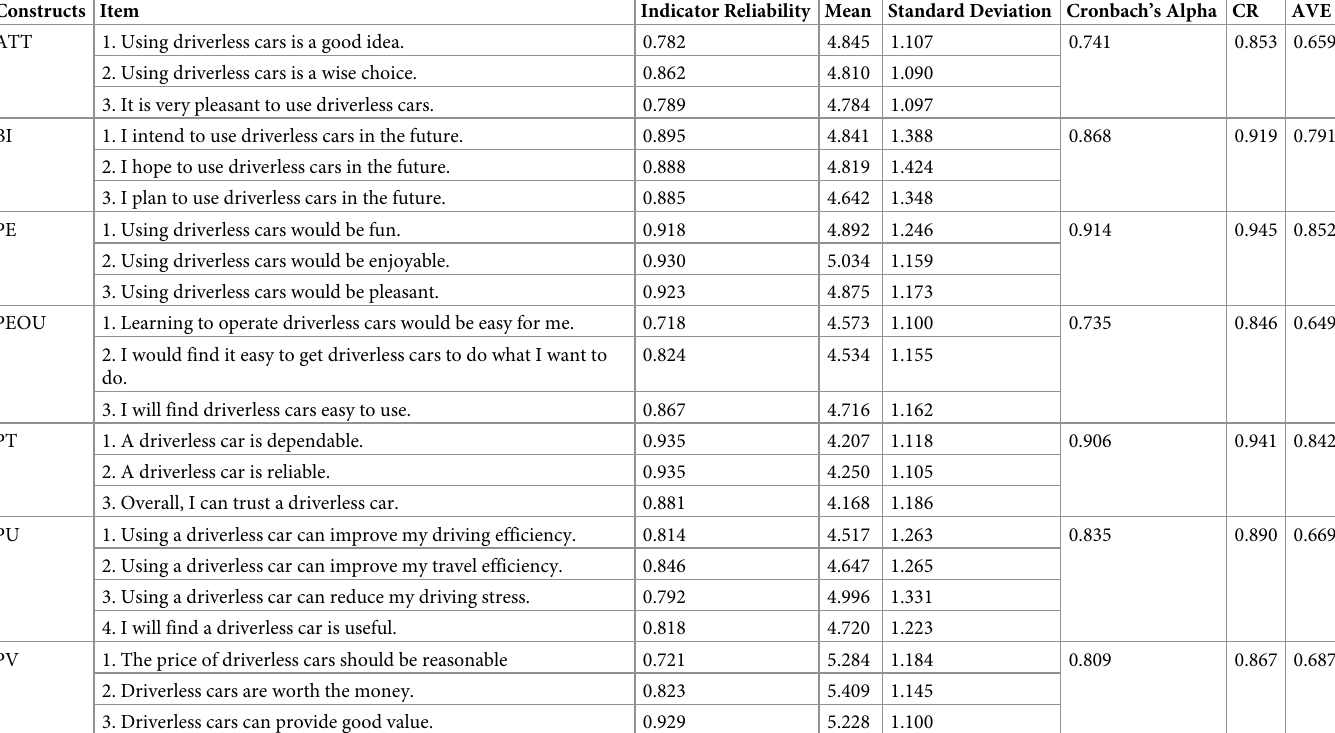
Table 2. Reliability and validity of variants.